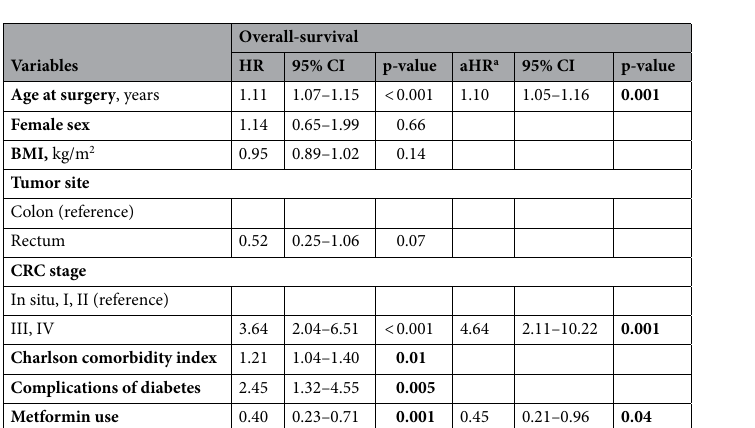
Figure 2. Survival curves comparing metformin users and non-users. ( a ) Overall survival, ( b ) disease-free survival.